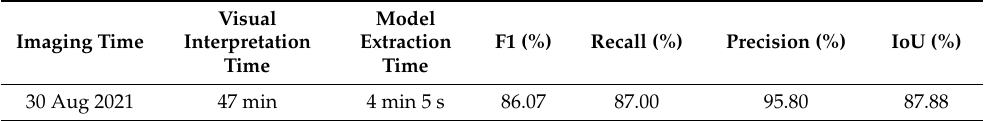
Table 6. BSL extraction accuracy of Deeplabv3+-M-CBAM in the transfer area. Imaging